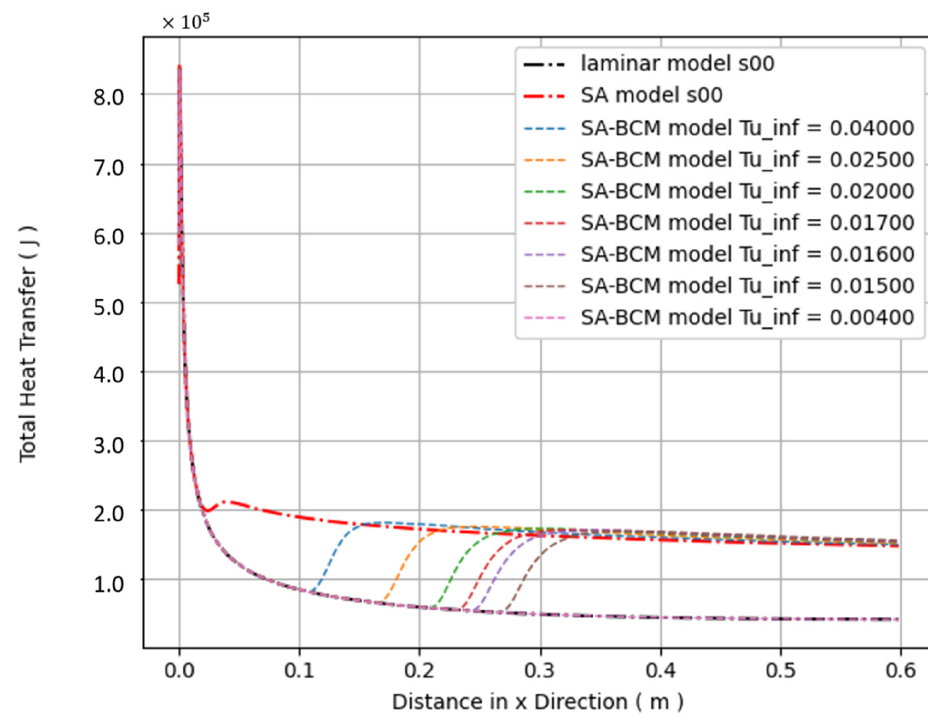
Figure 7. Calibration of freestream turbulence intensity.